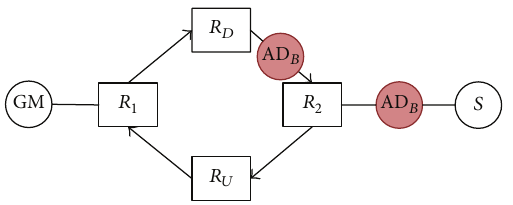
Figure 5: Scenario 𝐵 for the network, AD 𝐵 —an adversary.